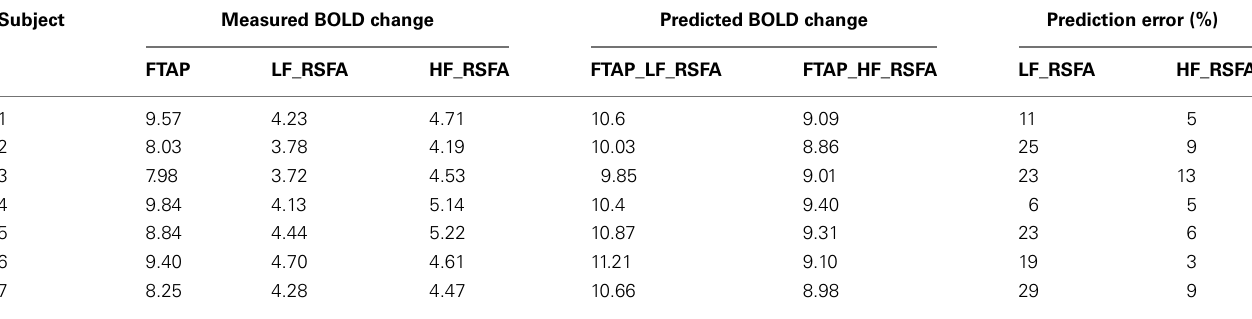
Table 2 | Prediction of task-induced response from the BH and RSFA signals in the second group of healthy